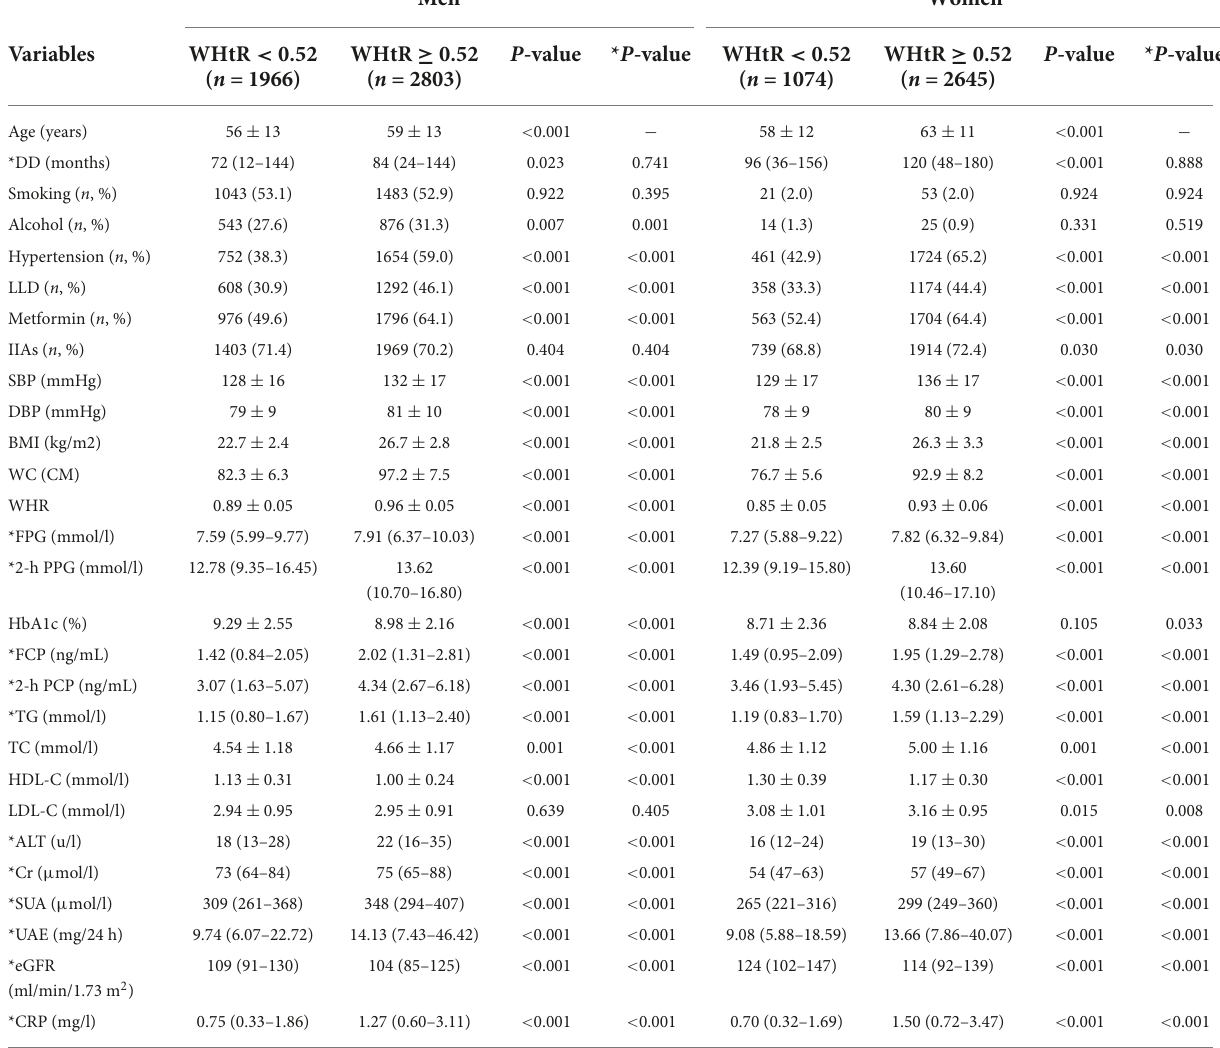
TABLE 1 The clinical characteristics of the